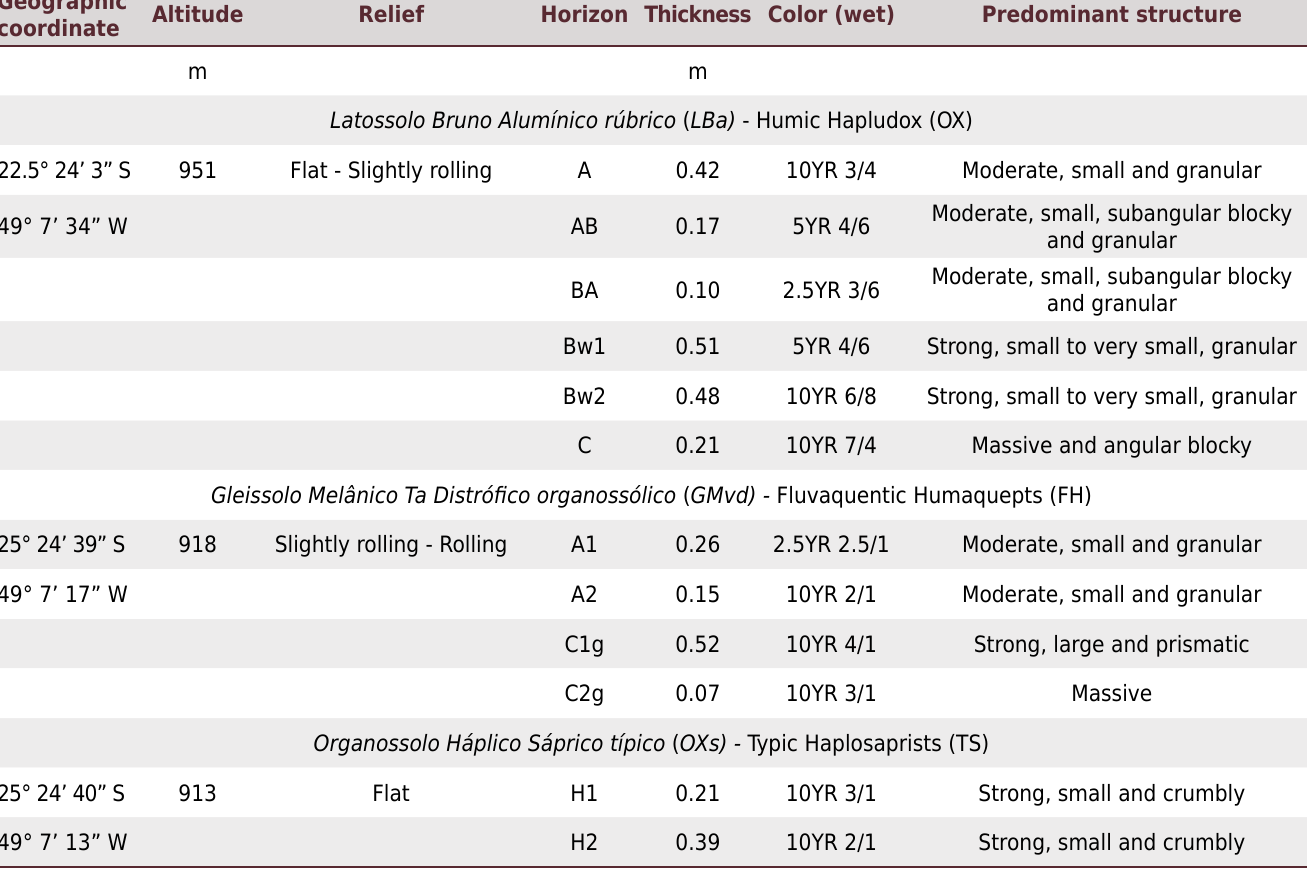
Table 1. General soil characterization: geomorphology and soil morphological description Geographic Altitude Relief Horizon Thickness Color (wet) Predominant coordinate